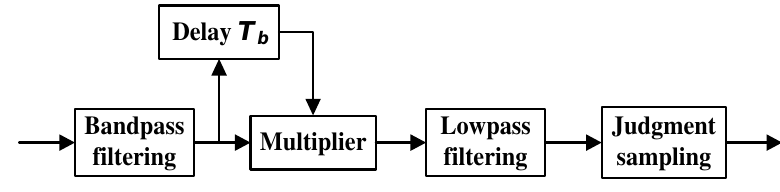
Figure 2. Differential coherence